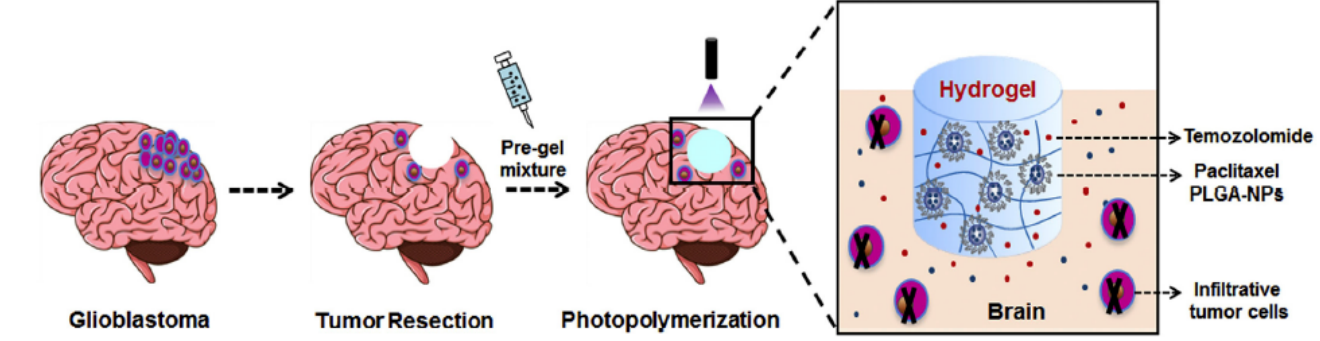
Figure 2. Codelivery of PTX and TMZ through a photopolymerizable hydrogel for the postresection treatment of glioblastoma. Reproduced from Ref. [46] with permission of the copyright holder.